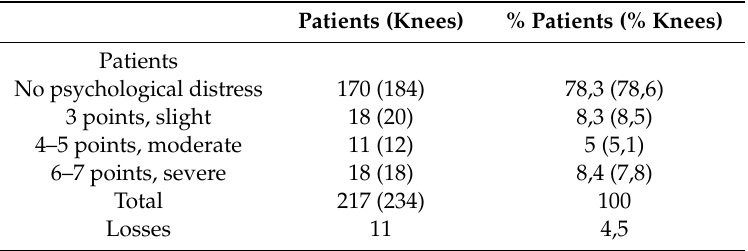
Table 6. Descriptive characteristics of the final score for psychological distress of the whole sample (conventional and hypoallergenic TKA).